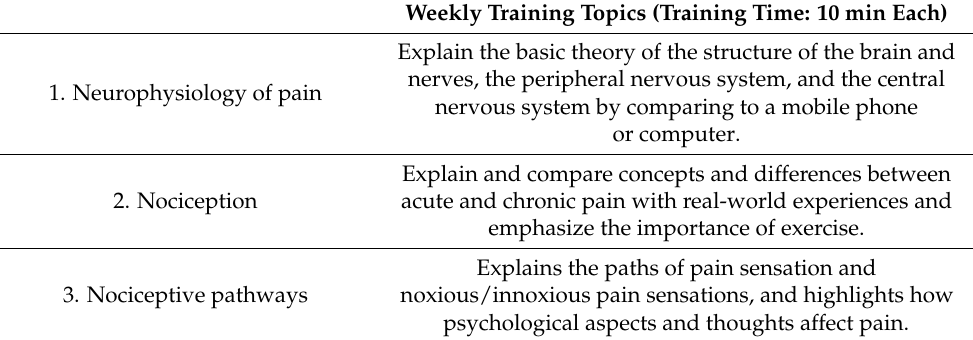
Table 1. Pain neuroscience education